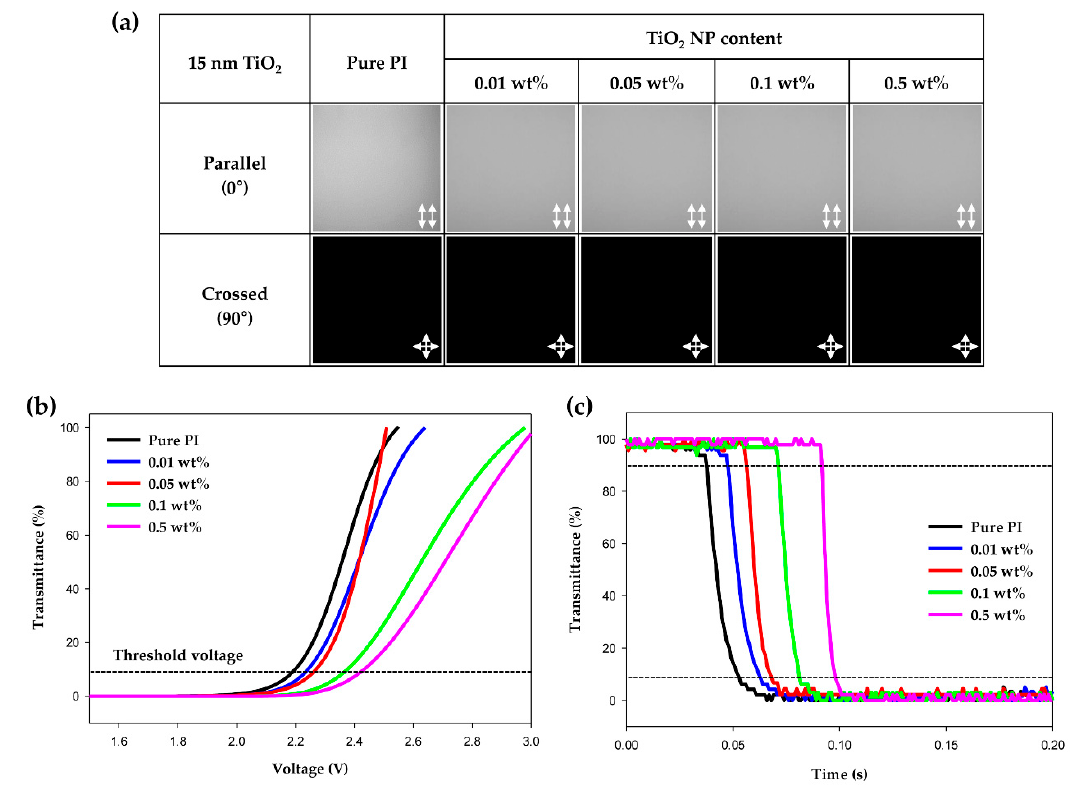
Figure 4. ( a ) Polarized optical microscopy (POM) images of the fabricated liquid crystal (LC) cells with pure polyimide and hybrid polyimide layers containing 15-nm-TiO 2 . ( b ) Voltage-transmittance (V-T) curves and ( c ) response time curves of the LC cells with hybrid polyimides and pure polyimide.